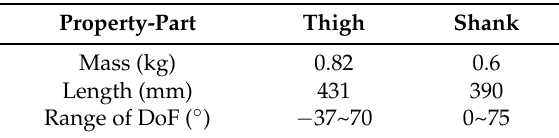
Table 1. Parameters of the mechanical